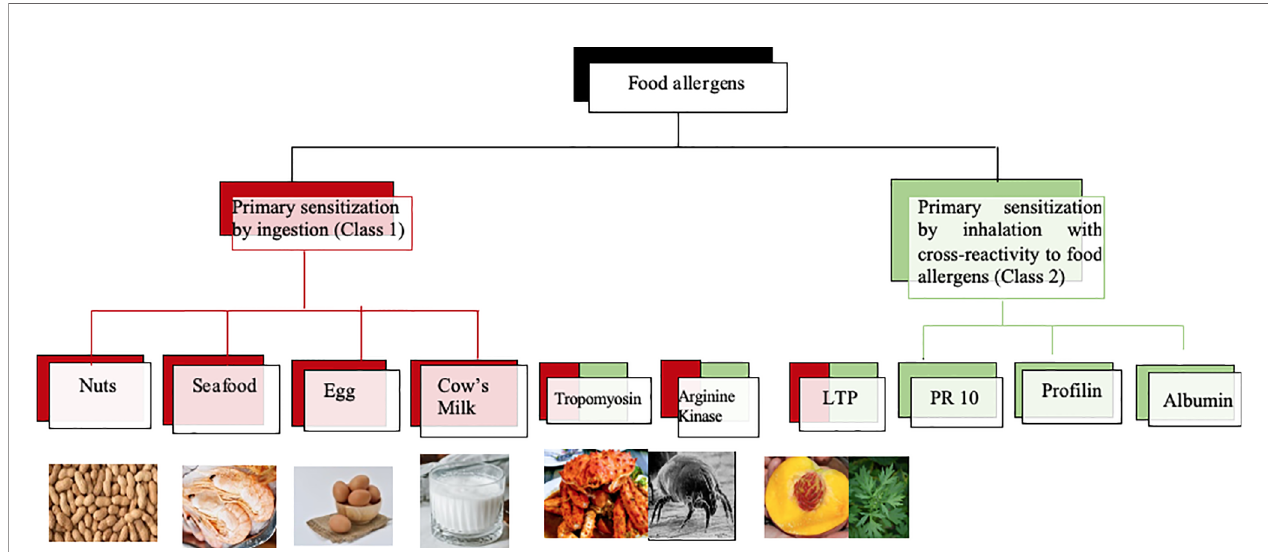
FIGURE 7 | Class 1 and class 2 food allergens/allergen sources with possible relevance for Chinese patients. Class 1 food allergens/allergen sources are indicated in red, class 2 food allergens in green whereas allergens which may behave as class 1 and 2 allergens contain red and green